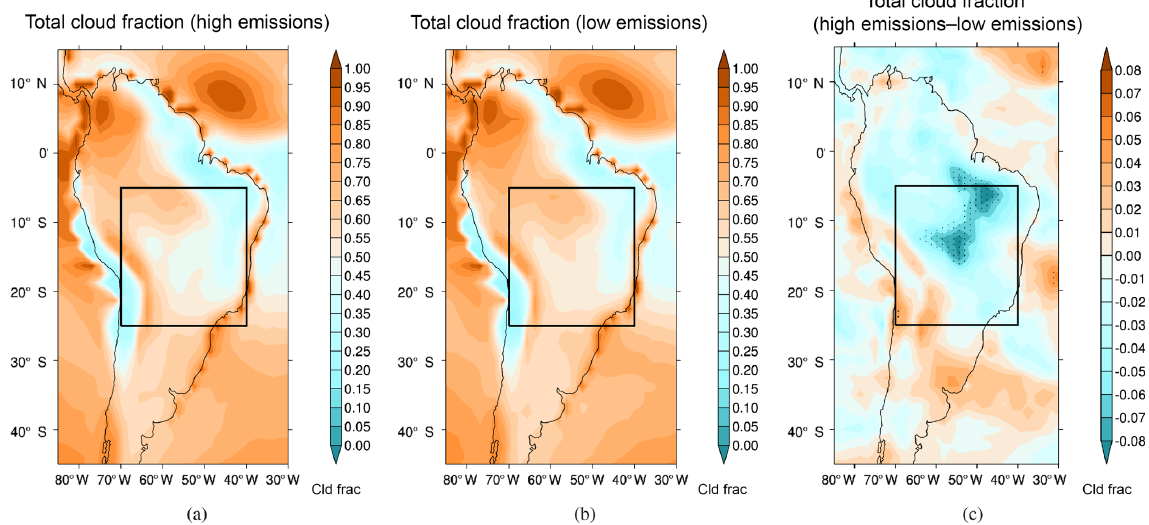
Figure 6. (a) The September mean cloud fraction for the high emissions experiment. (b) The September mean cloud fraction for the low emissions experiment. (c) Plot of the September difference in the cloud fraction between the high and low emissions experiment. Stippling represents 95% confidence